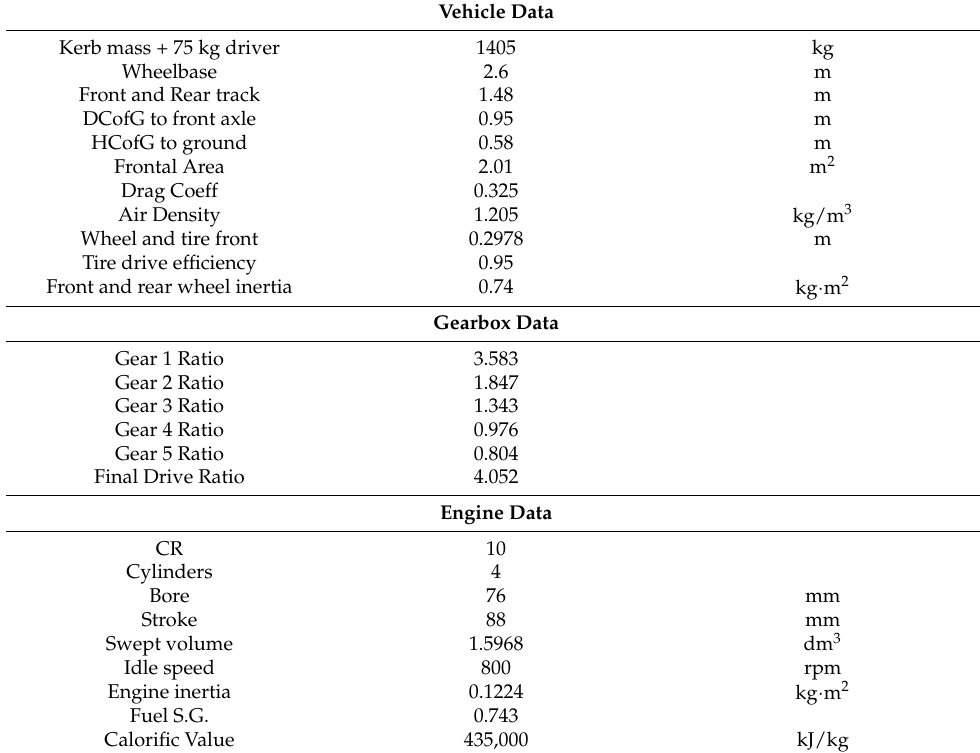
Table 1. Vehicle and engine